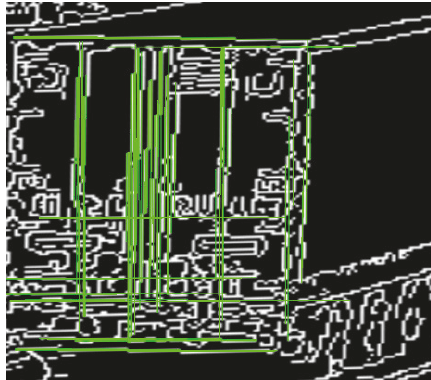
Figure 40: Extraction result of the line in the main view of